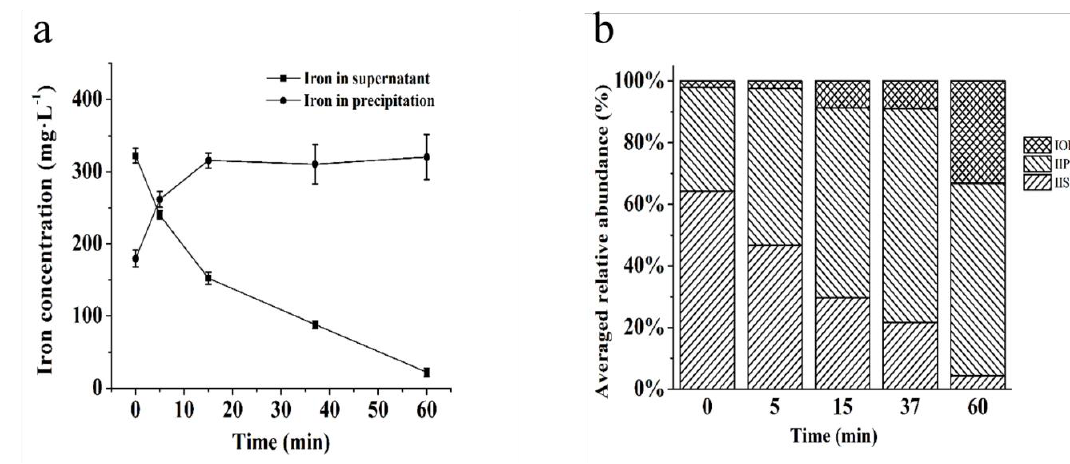
Figure 7. Iron distribution in the supernatant and precipitate ( a ). Averaged relative abundance of iron in each phase ( b ). IOE stands for iron abundance on the surface of electrode. IIP stands for iron abundance in the precipitate. IIS stands for iron abundance in the supernatant.